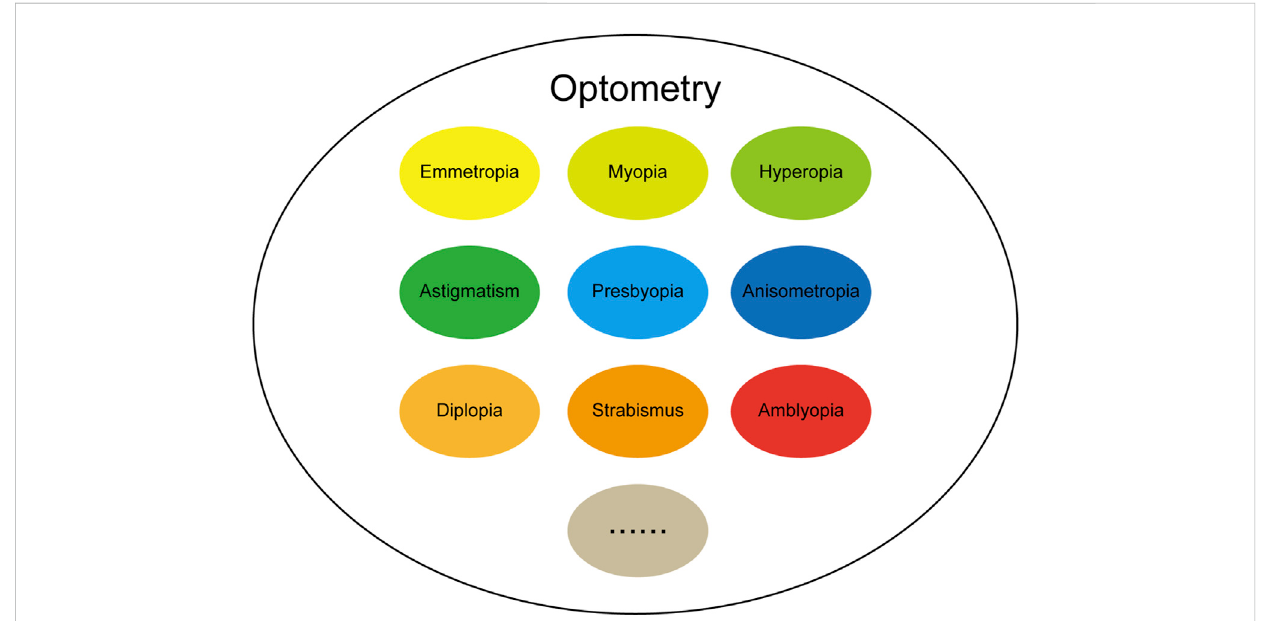
FIGURE 2 The basic composition of the fi eld of